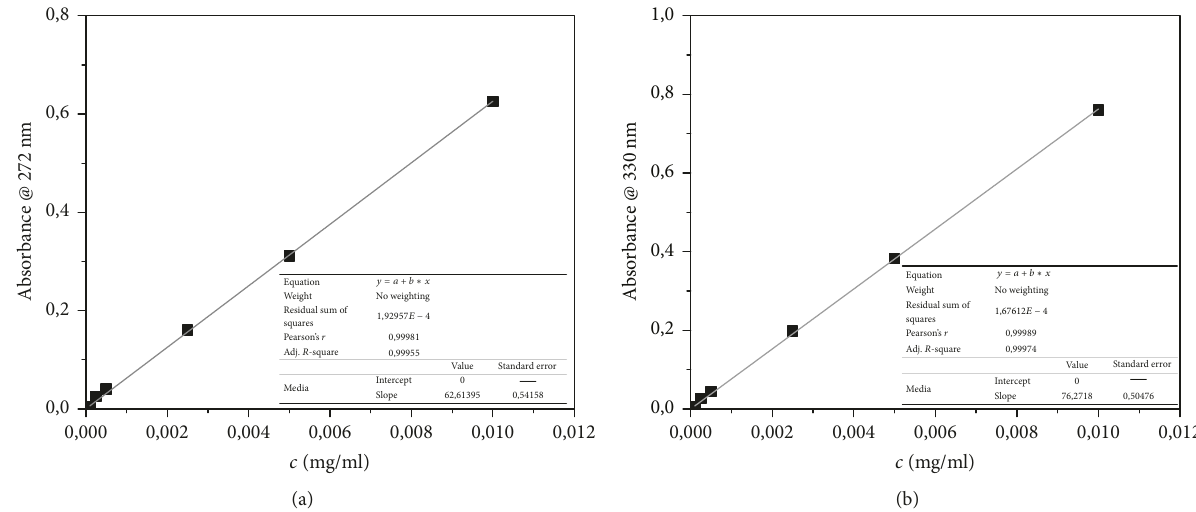
Figure 2: Absorbance values of caffeine (a) and CGA (b) as a function of the solution concentrations. The data correlation was calculated by a linear fit. The tables in the graph report the obtained parameters.